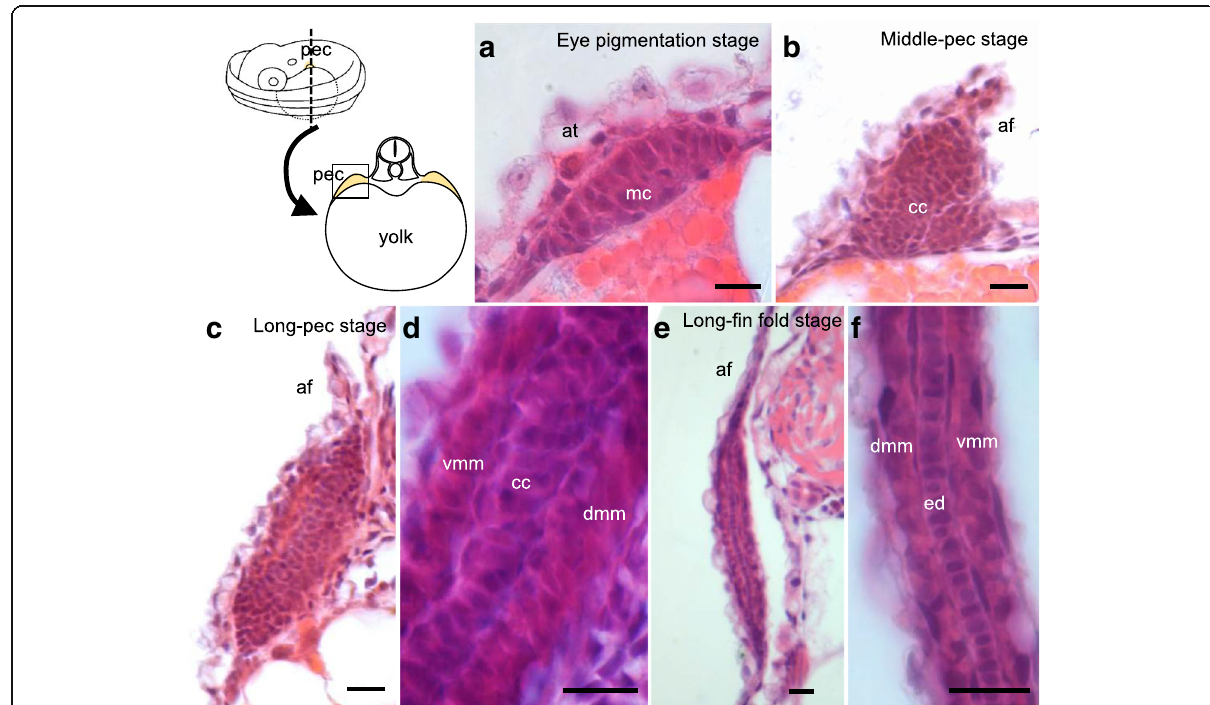
Fig. 3 Hematoxylin-eosin staining of pectoral fin buds and early larval fins. Cross-sections of pectoral fin buds and early larval fins stained with hematoxylin and eosin ( a , b , c , e ) and magnified images ( d , f ) at the eye pigmentation stage ( a ; n = 1), middle-pec stage ( b ; n = 1), long-pec stage ( c , d ; n = 1), and long fin-fold stage ( e , f ; n = 1). at, apical thickening; af, apical fin fold; cc, chondrogenic condensation; dmm, dorsal muscle mass; ed., endoskeletal disc; vmm, ventral muscle mass; pec, pectoral fin. Scale bars, 10 μ